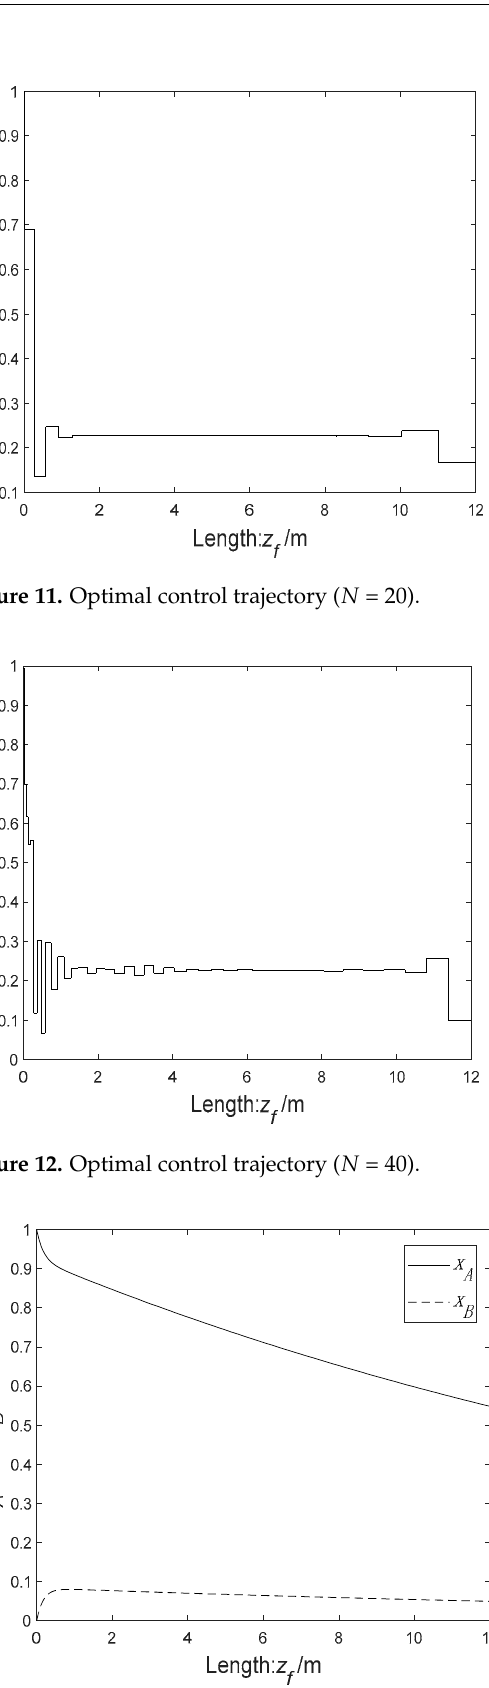
Figure 10. Optimal control trajectory (